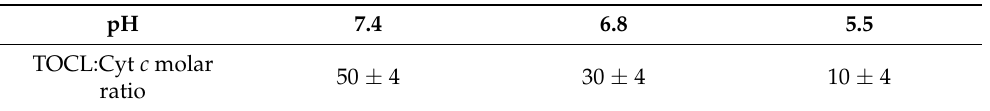
Table 2. TOCL:Cyt c ratios in the complex at different pH values in aqueous solutions (KH 2 PO 4 , 20 mM) by thermal lens spectrometry; p = 0.95, n = 3.